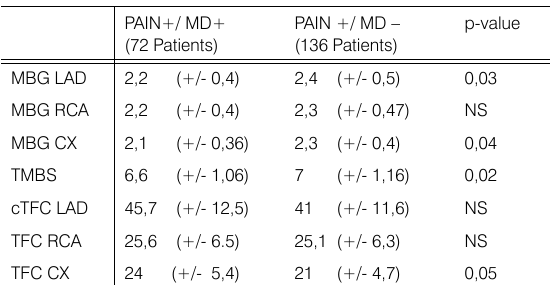
Table 1. Comparison of TFC, MBG and TMBS between diabetic patients with chest pain than non-diabetic patients with chest pain. PAIN+/ MD+ (72 Patients)